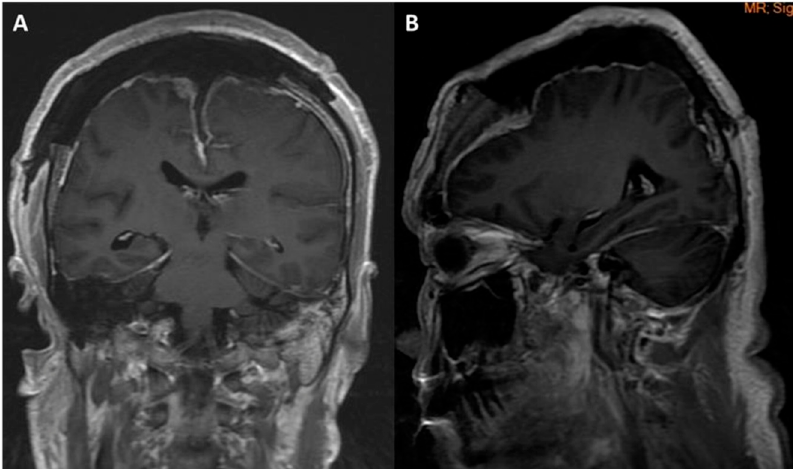
Figure 4. Post-operation brain MRI image revealed gross total tumor removal without hemorrhage or infarction: ( A ) coronal view; ( B ) sagittal view.